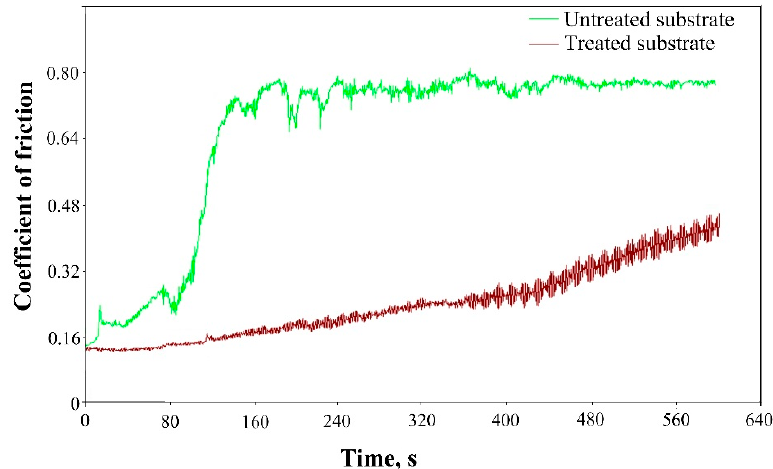
Figure 6. Coefficient of friction of bilayer TiN/TiO 2 coatings deposited on electron beam-treated and Figure 6. Coe ffi cient of friction of bilayer TiN / TiO 2 coatings deposited on electron beam-treated and untreated Co–Cr substrate. untreated Co–Cr